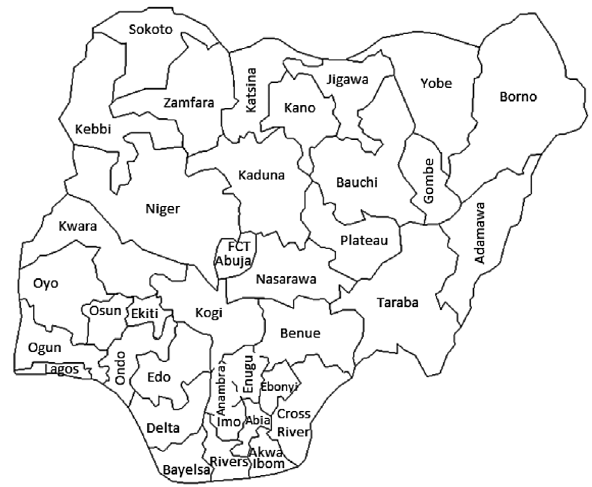
Figure 2: Spatial spread of fertility in Nigeria (95% CI).